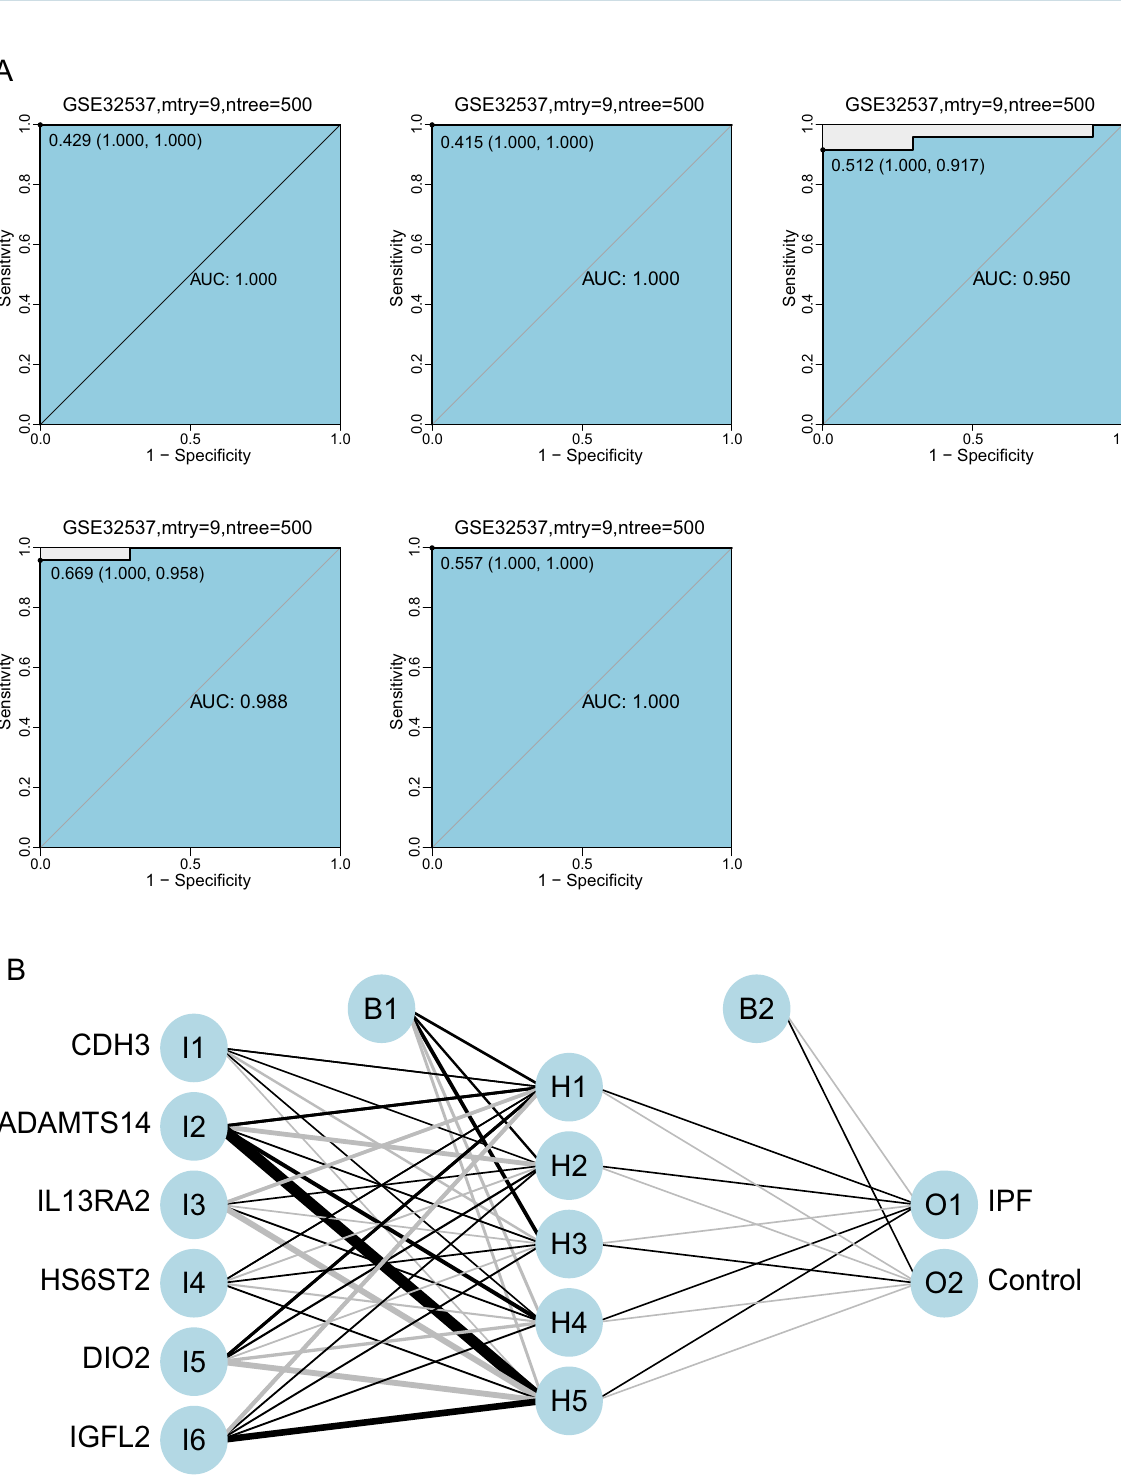
Figure 4. Construction of the artificial neural network model. ( A ) Verification of the ROC curve results by the five-time cross-validation model in GSE32537. The points marked on the ROC curve are the optimal threshold points, and the values in parentheses represent sensitivity and specificity. The AUC value is the area under the ROC curve. ( B ) Results of neural network